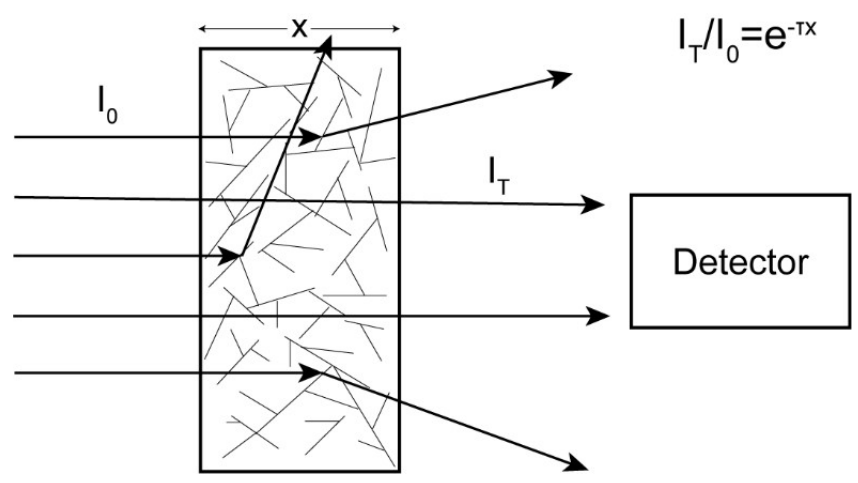
Figure 2. The incoming light enters the solution and is scattered by the rods. The transmitted light is collected by a detector. A ratio of the transmitted light to incoming light can be used to determine the turbidity. The absorption coefficient, α , is then related to absorbance, A , by